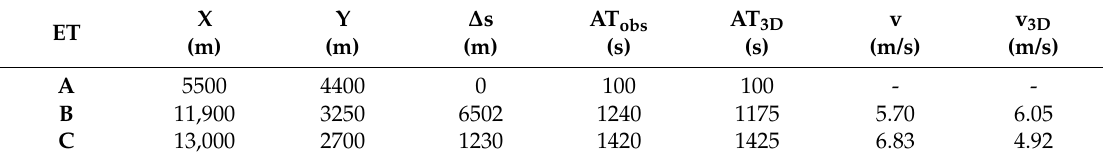
Table 2. Comparison of the arrival times at the three Electrical Transformers (ETs), the observed wave arrival time (AT obs ), the distance between each transformer and the following one ( ∆ s), the mean velocity of the flood wave between transformers sections (v), the mean value of flow arrival times at each transformer computed through 3D model (AT 3D ), and the mean velocity of the flood wave simulated by the 3D model (v 3D ).